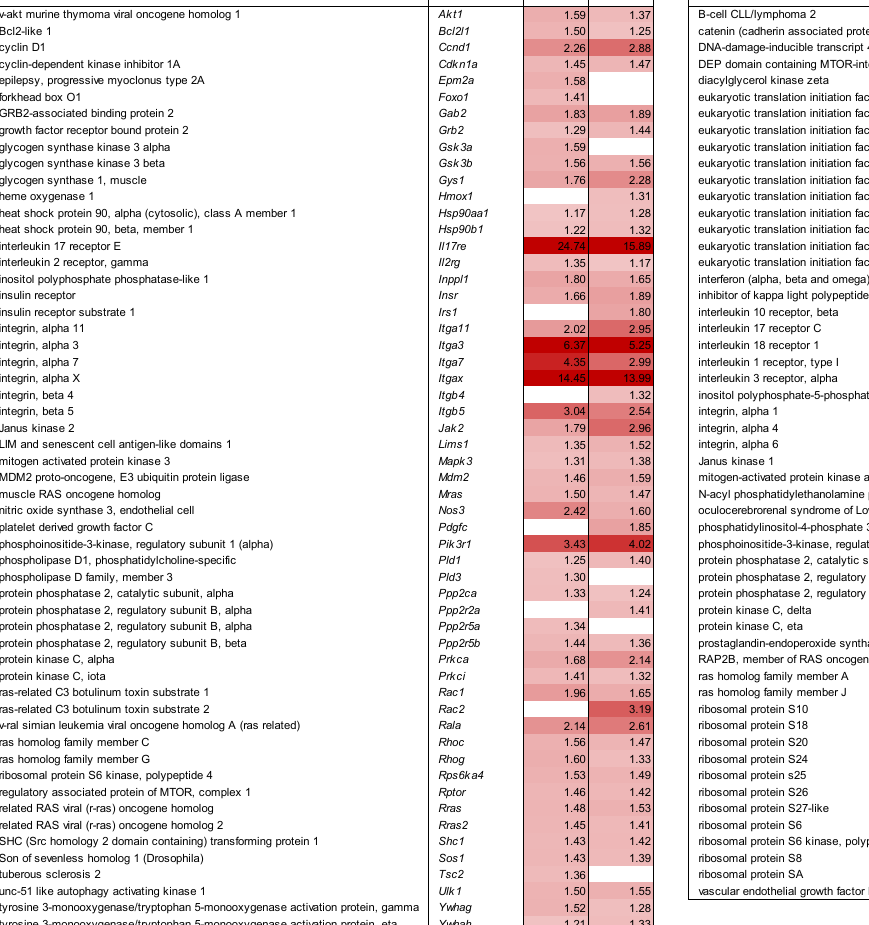
Figure 5. Alterations in the expression of genes involved in AKT/mTOR signaling. The transcript levels were identified by microarray analyses as a result of either Ren(1a–9) or Ren(2–9) overexpression as compared with pIRES H9C2 control cells. The red color indicates genes with increased mRNA levels and the blue color indicates those with decreased mRNA levels as compared with pIRES controls, while the white color indicates not significantly altered genes with q > 0.05. Shown are only significantly altered genes ( q < 0.05) that exhibit a fold change of ≥ |1.3| in at least one group